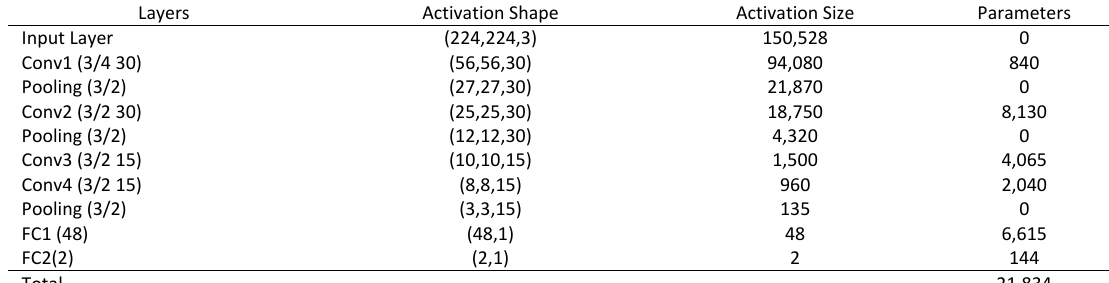
Table 9: The Number of parameters of EfficientParkingNet